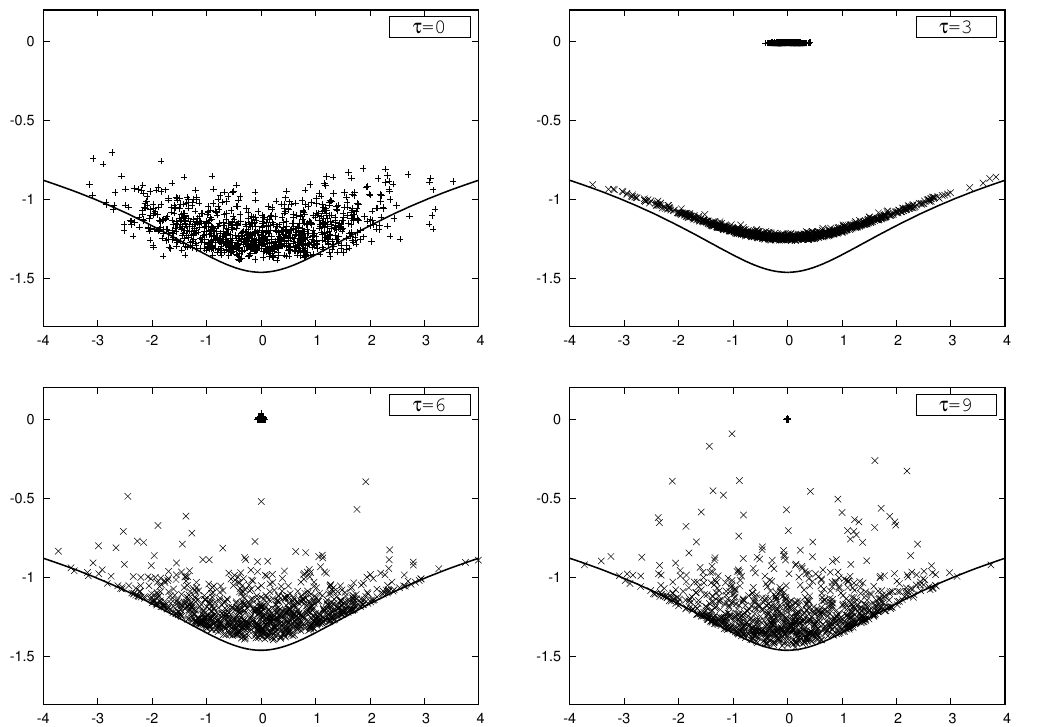
Figure 1 . The distribution of z (represented by \+") and (cid:13)owed con(cid:12)gurations (represented by \ (cid:2) ") obtained by applying the CLM to (4.2) are plotted for (cid:28) = 0 ; 3 ; 6 ; 9 from Top-Left to Bottom- Right. The solid line represents the Lefschetz thimble. At (cid:28) = 0, the distribution of z and (cid:13)owed con(cid:12)gurations